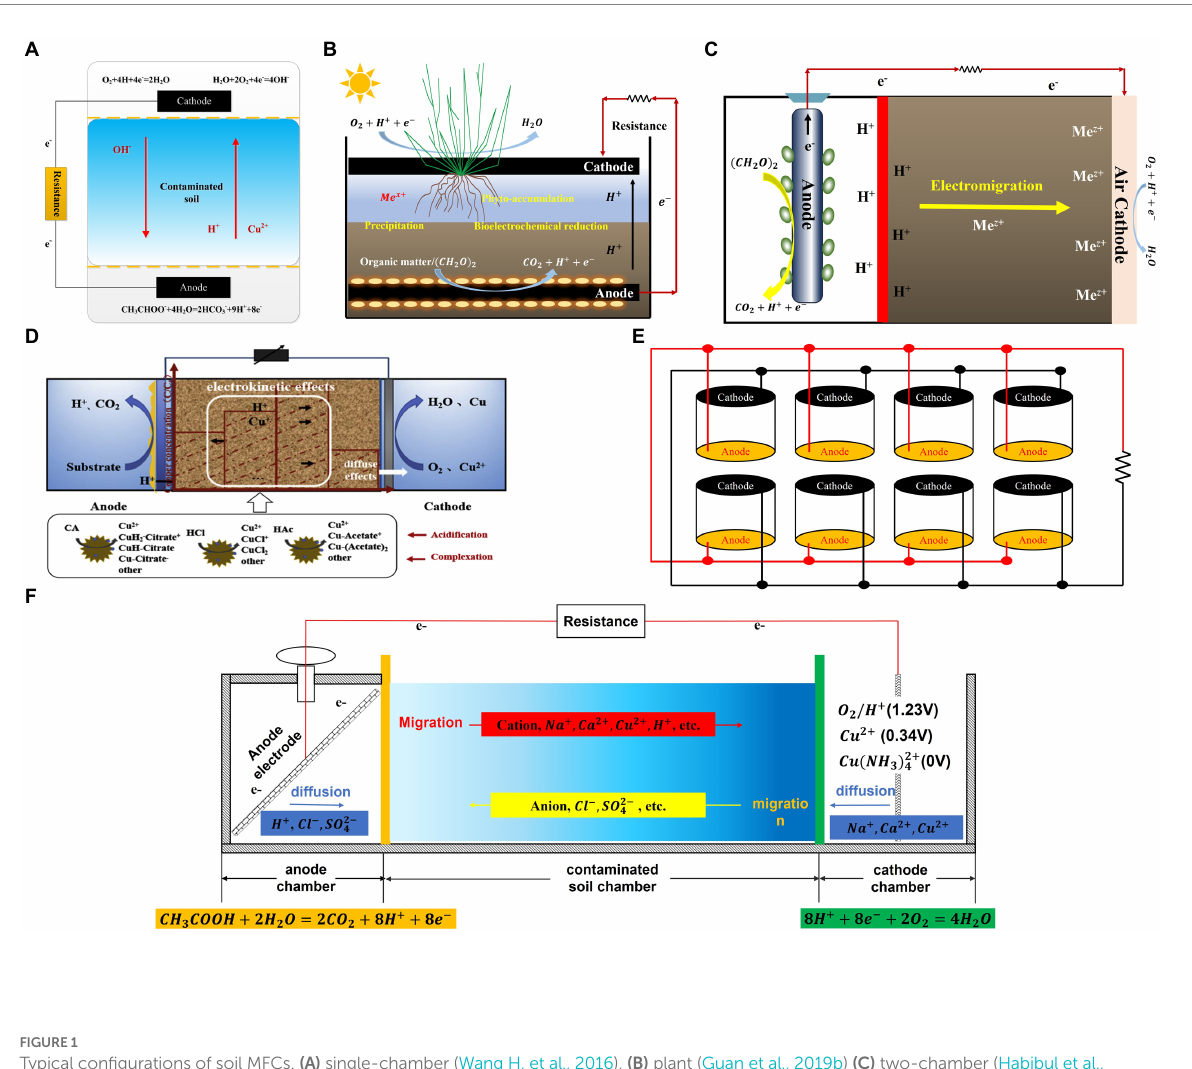
FIGURE 1 Typical configurations of soil MFCs. (A) single-chamber (Wang H. et al., 2016), (B) plant (Guan et al., 2019b) (C) two-chamber (Habibul et al., 2016a), (D) three-chamber (Zhang et al., 2020a), (E) stack MFCs (Dziegielowski et al., 2021), and (F) Mass transfer of multi-ions in soil MFC induced by diffusion and migration. All panels are with the permission from publishers’